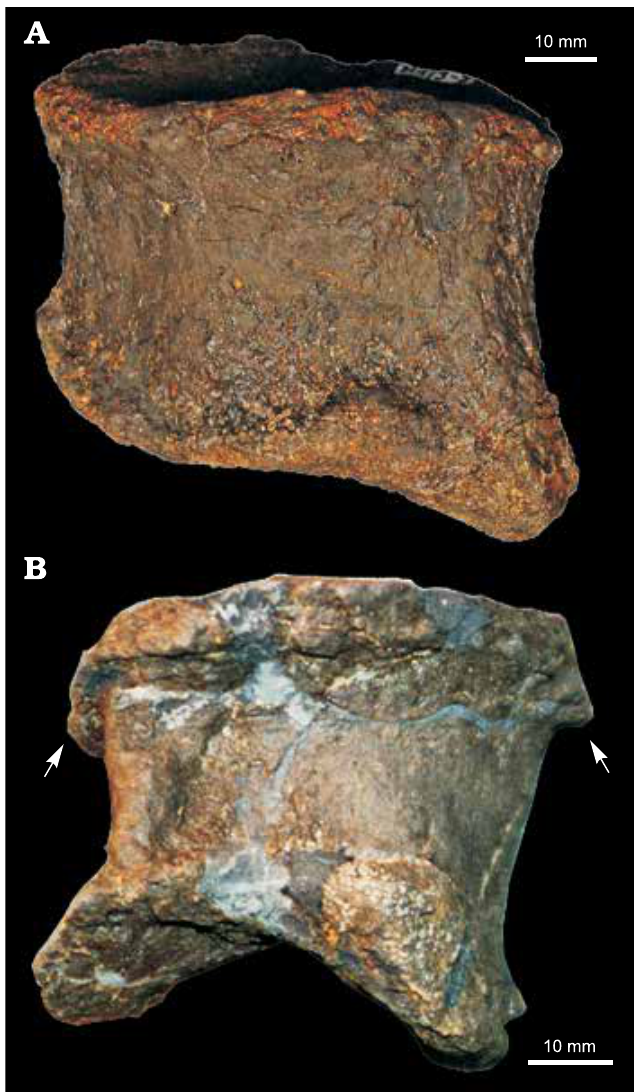
Fig. 11. Comparison of the normal development of articular surfaces of phalanges of diplodocid sauropod SMA 0087 (php II-1, A ) with the patho- logical elements of camarasaurid sauropod SMA 0002 (php III-1, B ); both from the Upper Jurassic Morrison Formation, Howe Ranch, Wyoming, USA. Note the considerable extension of the lateral spurs in SMA